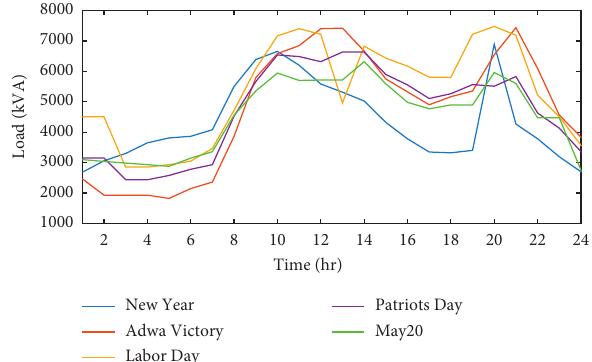
Figure 6: Hourly load profile of national holidays in 2019/20.